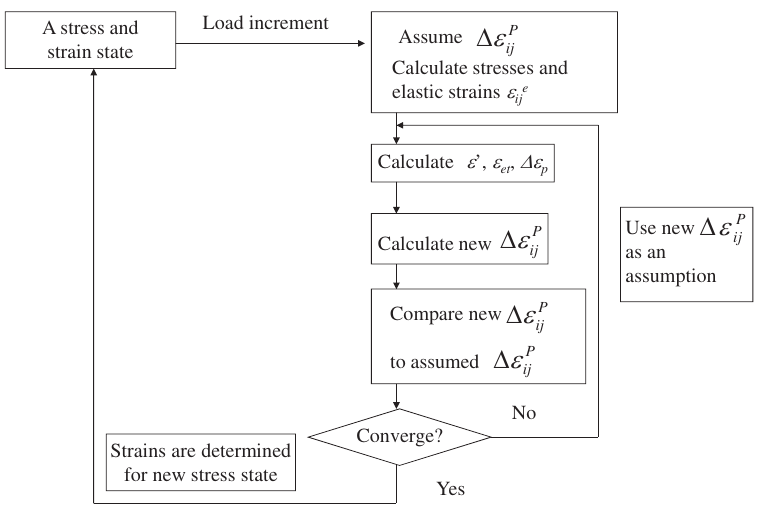
Figure 2 Procedure for determining plastic strains using the method of successive elastic